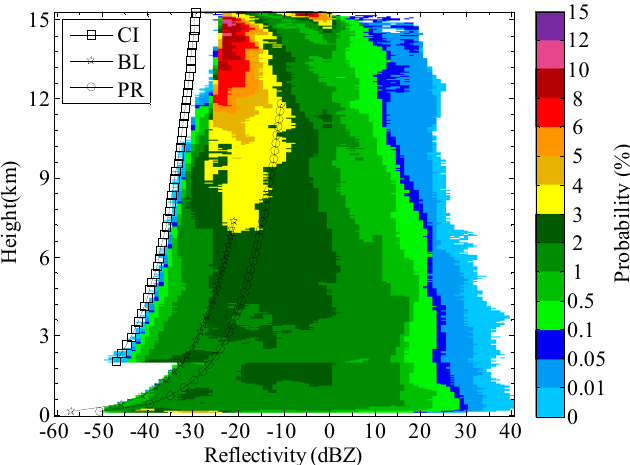
Figure 1. Statistical probability distribution of radar-measured reflectivity at different heights, collected over the Tibetan Plateau (TP) from June to August 2014 and July to September 2015. The spectrogram illustrates the radar’s actual d etection capability for weak and strong meteorological targets, and the marked curves represent the theoretical sensitivities of three operational modes. In the figure, CI, BL, and PR represent cirrus mode, boundary mode, and precipitation mode, respectively.